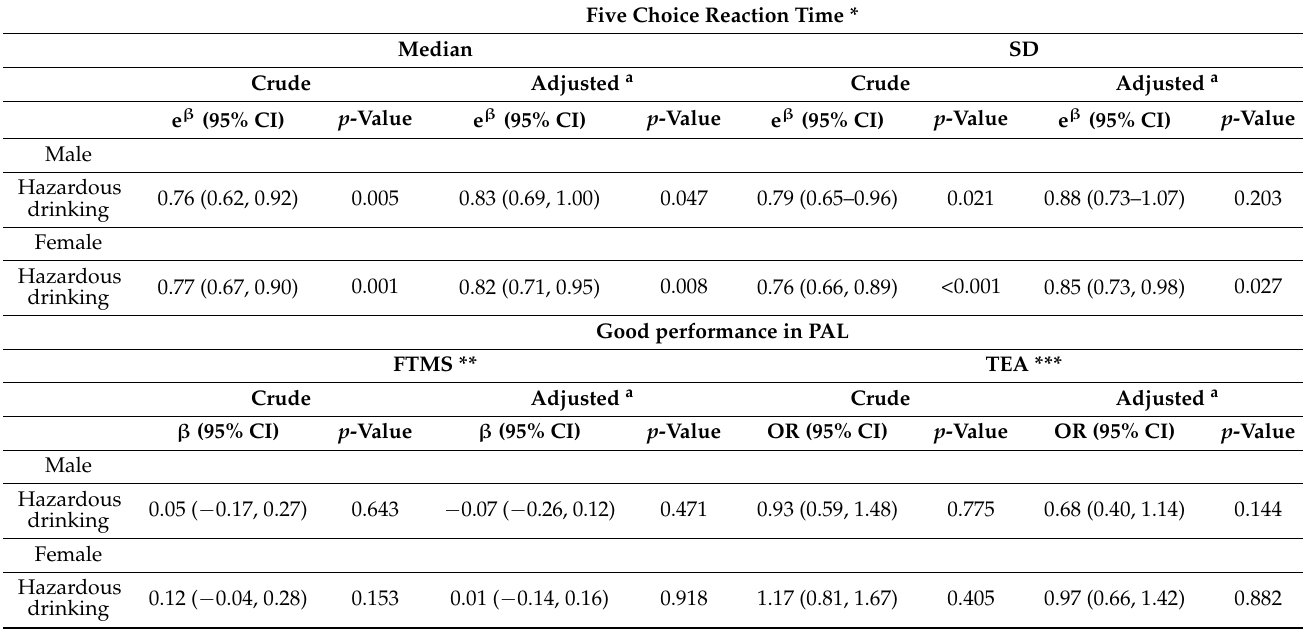
Table 2. Association of reaction time and visual memory with hazardous drinking ψ in bipolar